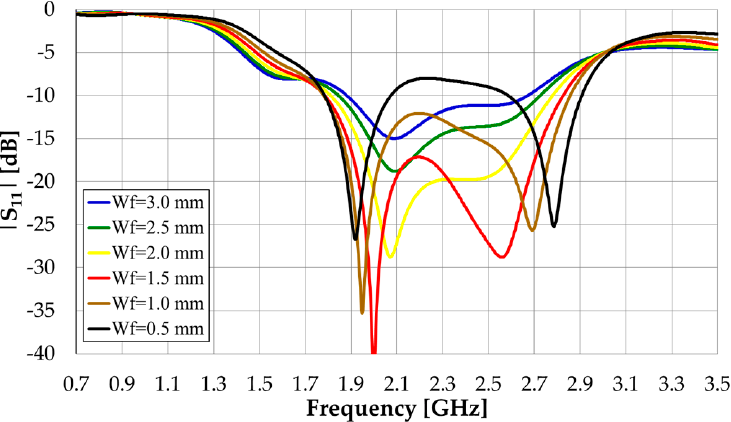
Figure 2. CST simulated results of the straight monopole input reflection coefficient amplitude. We define the impedance bandwidth using the usual |S 11 | = − 10 dB reference level, which corresponds to a 10% reflected power level. With this criterion, the larger bandwidth is obtained for W f = 1.0 mm and is about 46% (1.78–2.86 GHz), far from the required 133.3% or 5:1 (0.7–3.5 GHz), as